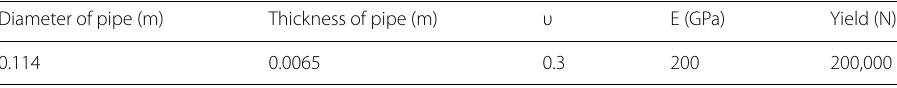
Table 8 Parameters used for modelling the umbrellas Diameter of pipe (m)